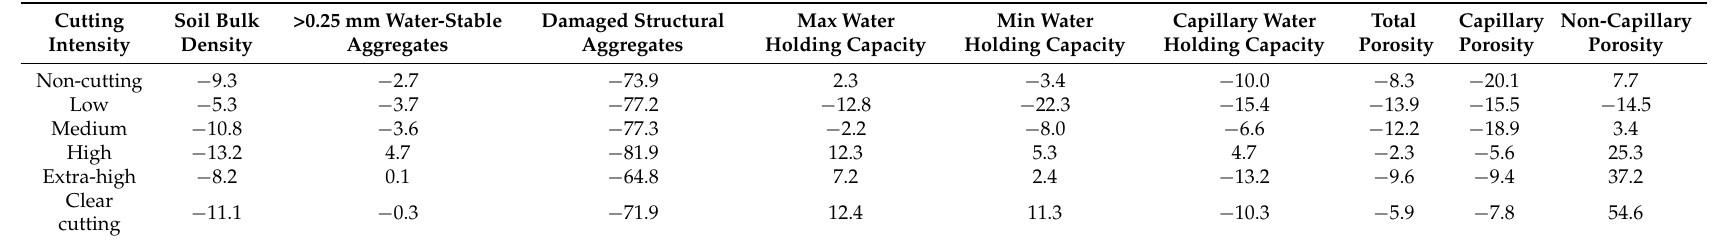
Table 4. Percentage change in soil physical properties between 10 and 15 years after